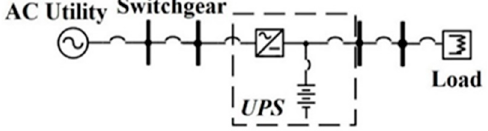
Figure 10. Reliability model of a conventional DC power distribution system.